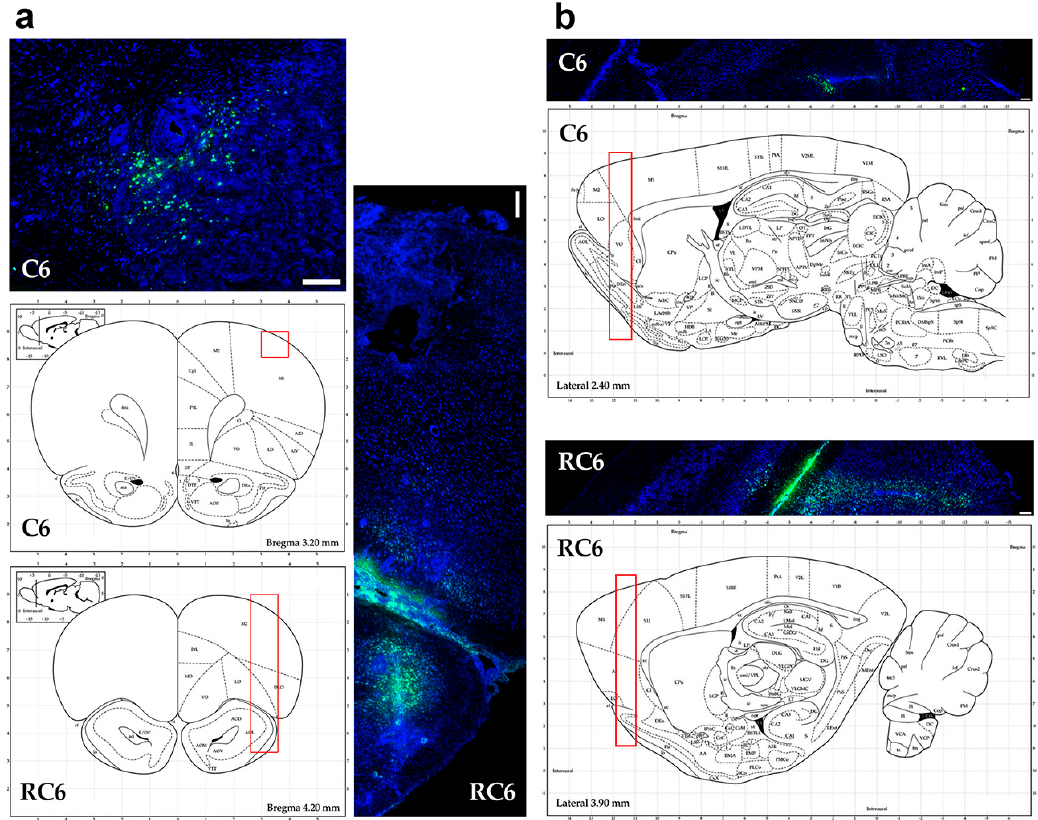
Figure 4. Invasion of C6 and RC6 cells 10 days after inoculation. ( a ) Representative images of coronal; ( b ) and sagittal sections of Wistar rat brain from C6 and RC6 group. Inoculated cells were stained with fluorescent dye FB ( green ). Nuclei were counterstained with PI ( blue ). Scale bar = 200 µ m. Rat brain schemes were taken from Rat Brain Atlas [18].